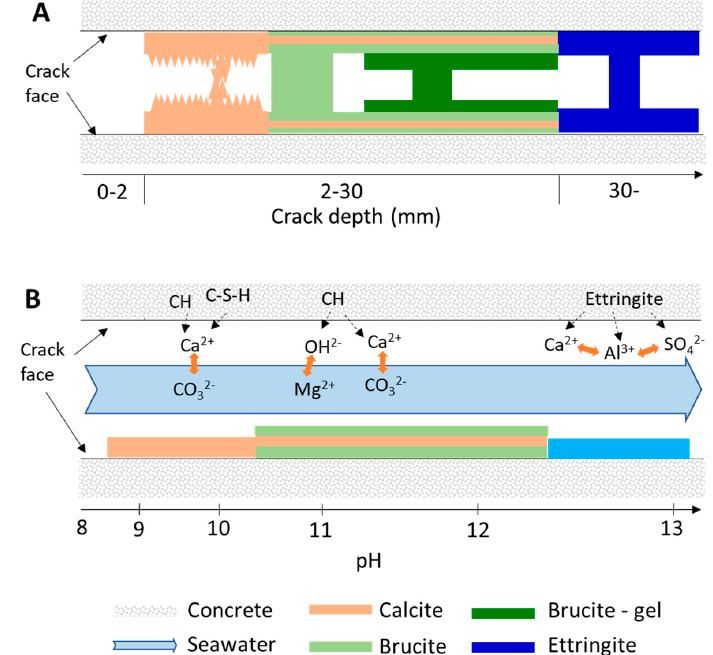
Figure 12. Illustration of ( A ) Observed mineralogical sequence of self-healing products with increased crack depth; ( B ) proposed self-healing mechanism. Only main components contributing to self-healing are indicated.